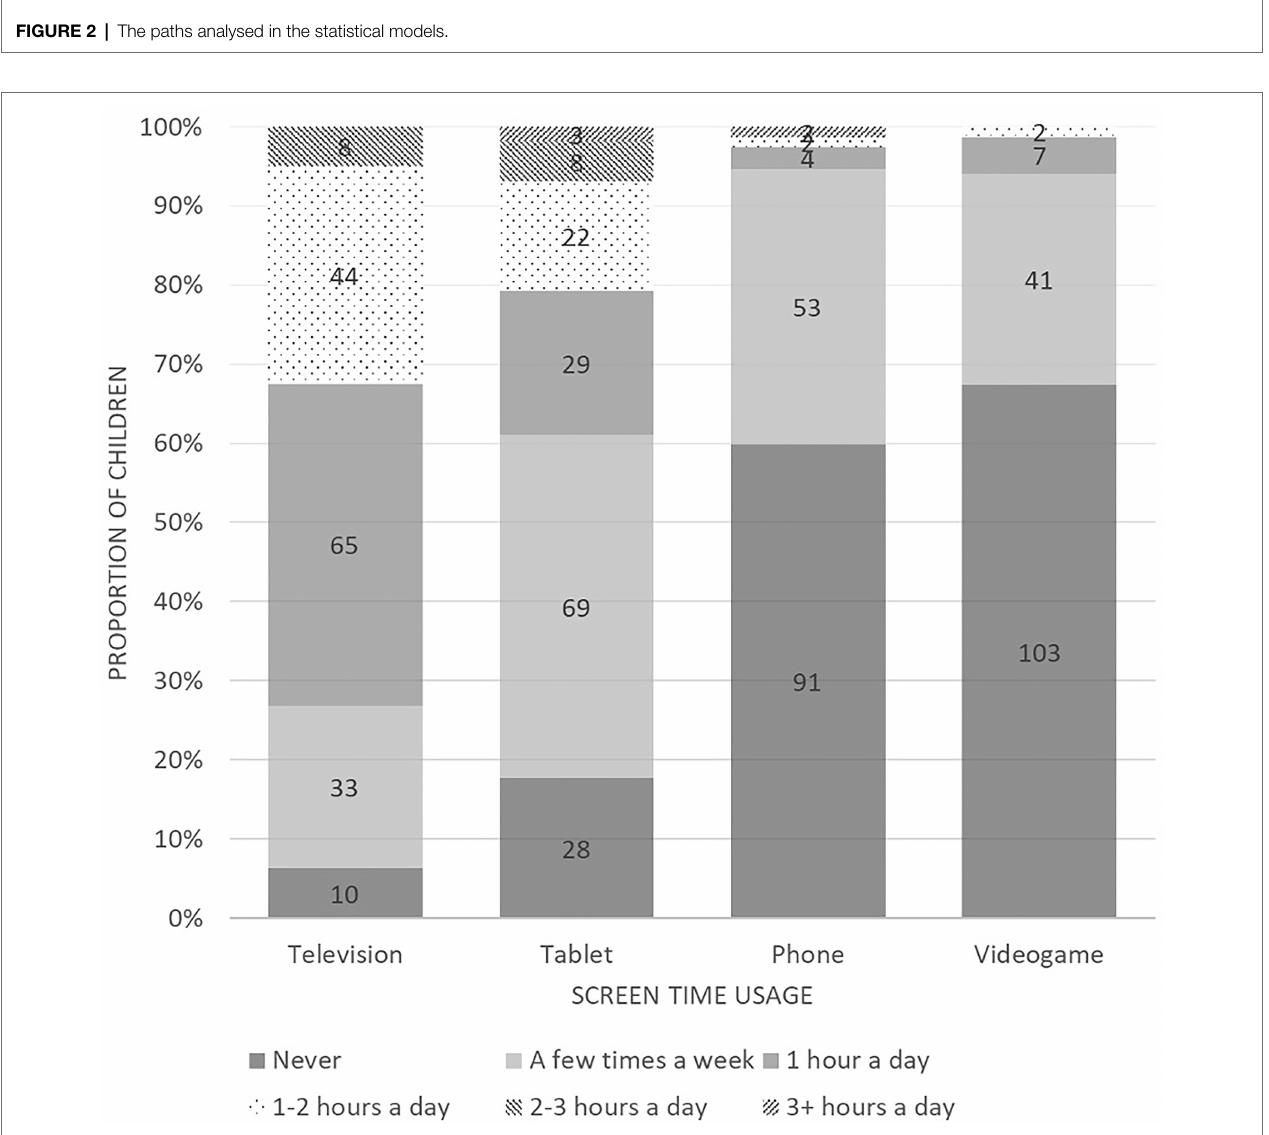
FIGURE 3 | The proportion of children who spent time on each device during weekdays graphed by device type.